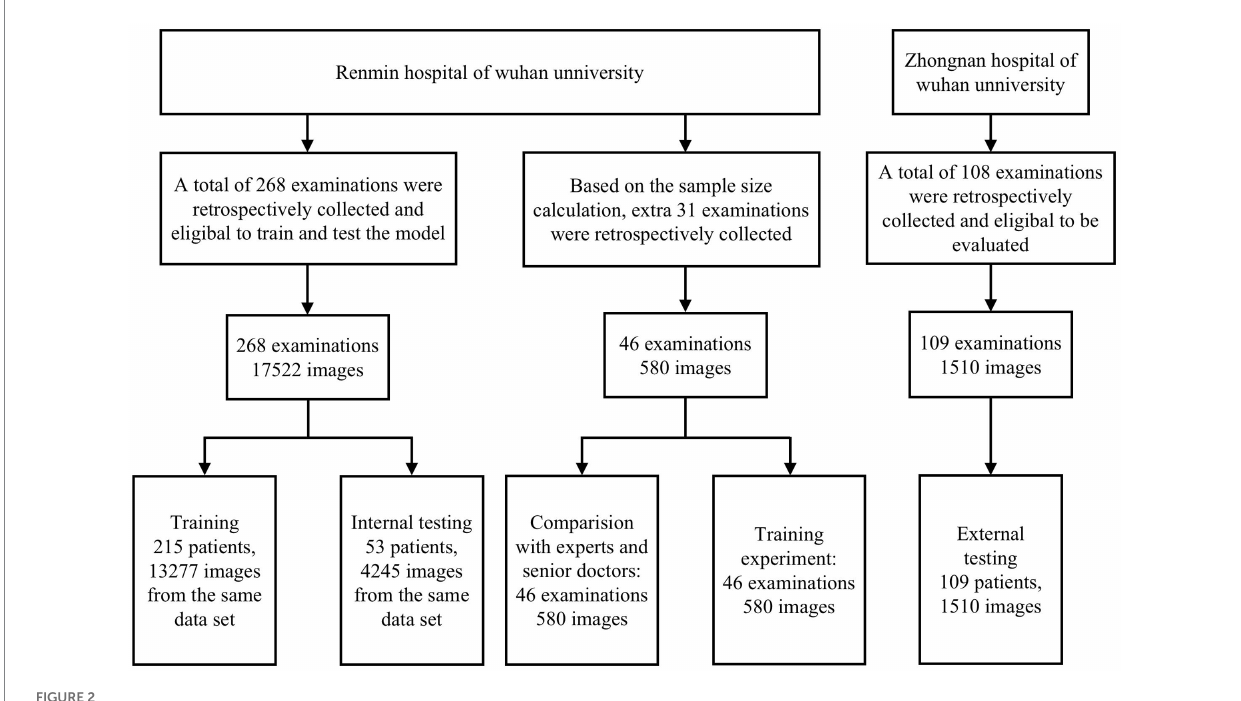
FIGURE 2 Flowchart of the model development and